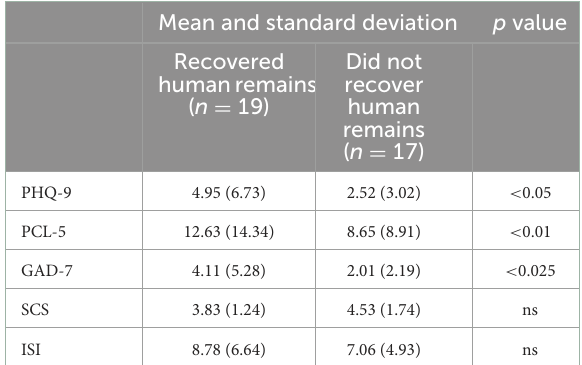
TABLE 4 Mental health symptoms among responders who recovered human